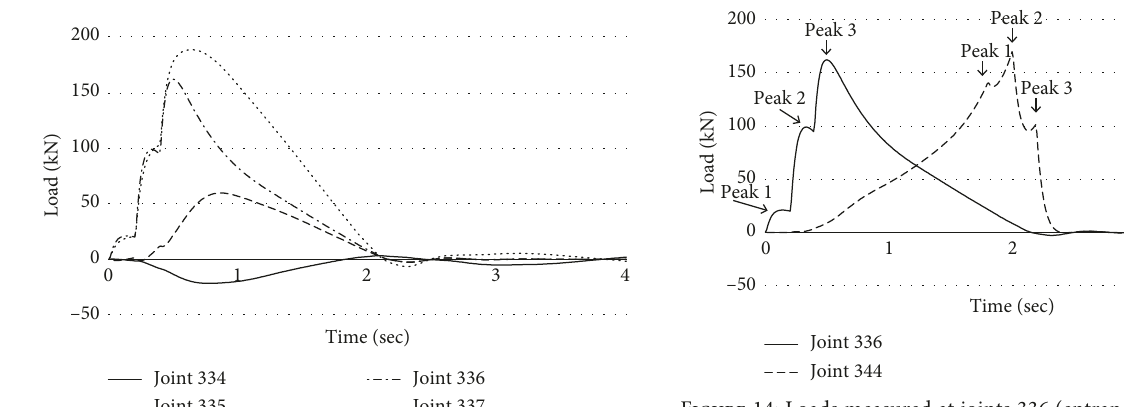
Figure 14: Loads measured at joints 336 (entrance) and 344 (exit) for the vehicle running at a speed of 80 km/h.